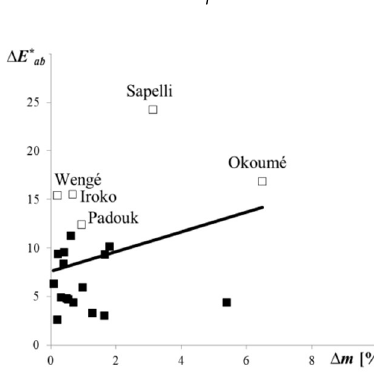
Figure 6. Linear correlations between the total colour differences ∆ E ∗ ab and the weight losses ∆ m of 21 tropical woods exposed 6 weeks to C. puteana